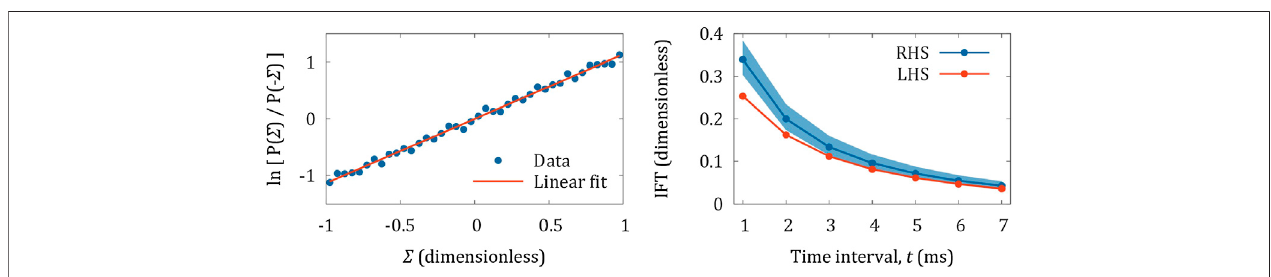
FIGURE 5 | Experimental tests of the FT. Left hand side: detailed FT plotted as the natural logarithm of Eq. 1 , with best fi t straight line with gradient ≈ 1 . 14. Right hand side: left and right hand sides of the integrated FT, Eq. 2 .